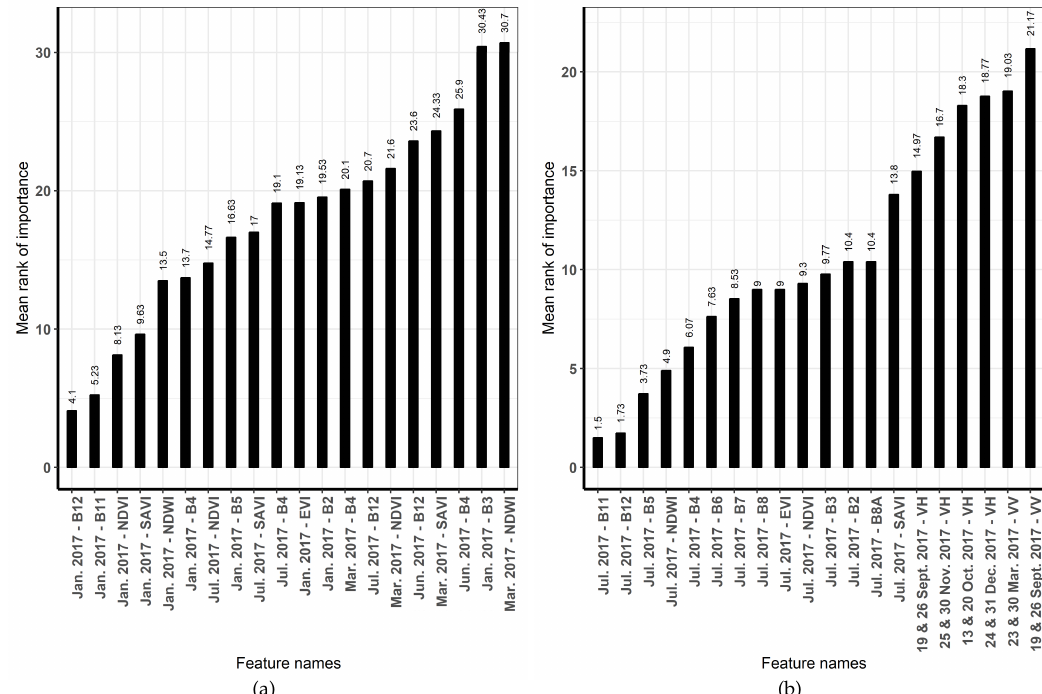
Figure 6. Mean rank of importance of the most important features for the combined use of Sentinel-1 and 2 data for ( a ) the Spanish study area and ( b ) the Brazilian study